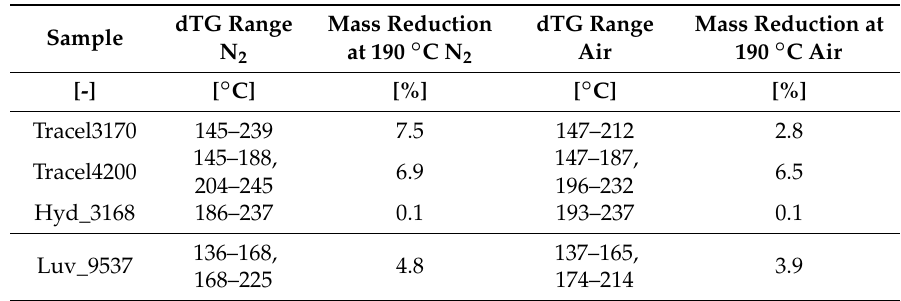
Figure 3. Thermogravimetric analysis (TGA) results of foaming agents in nitrogen and air ( a ) mass reduction as a function of temperature (50–800 °C), ( b ) the rate of mass reduction as a function of temperature (50–800 °C). The broken line indicates the nitrogen atmosphere, while the continuous line indicates air. Table 2. The decomposition range of CBAs (dTG ranges relevant from the aspect of PLA extrusion processing) and mass reduction at 190 °C.